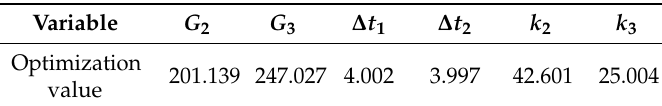
Table 7. Matlab optimization results.